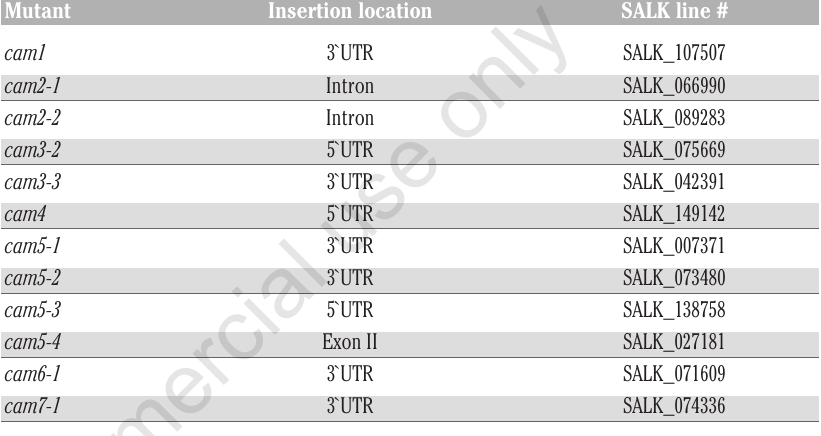
Table 1. Mutant lines with T-DNA insertion in calmodulin genes of A. thaliana used in this study. All seeds lines were obtained from Dr. Janet Braam, Rice University, except cam1 and cam4 seeds were obtained from the Arabidopsis Biological Research Stock Center, Ohio State University, Columbus, USA.